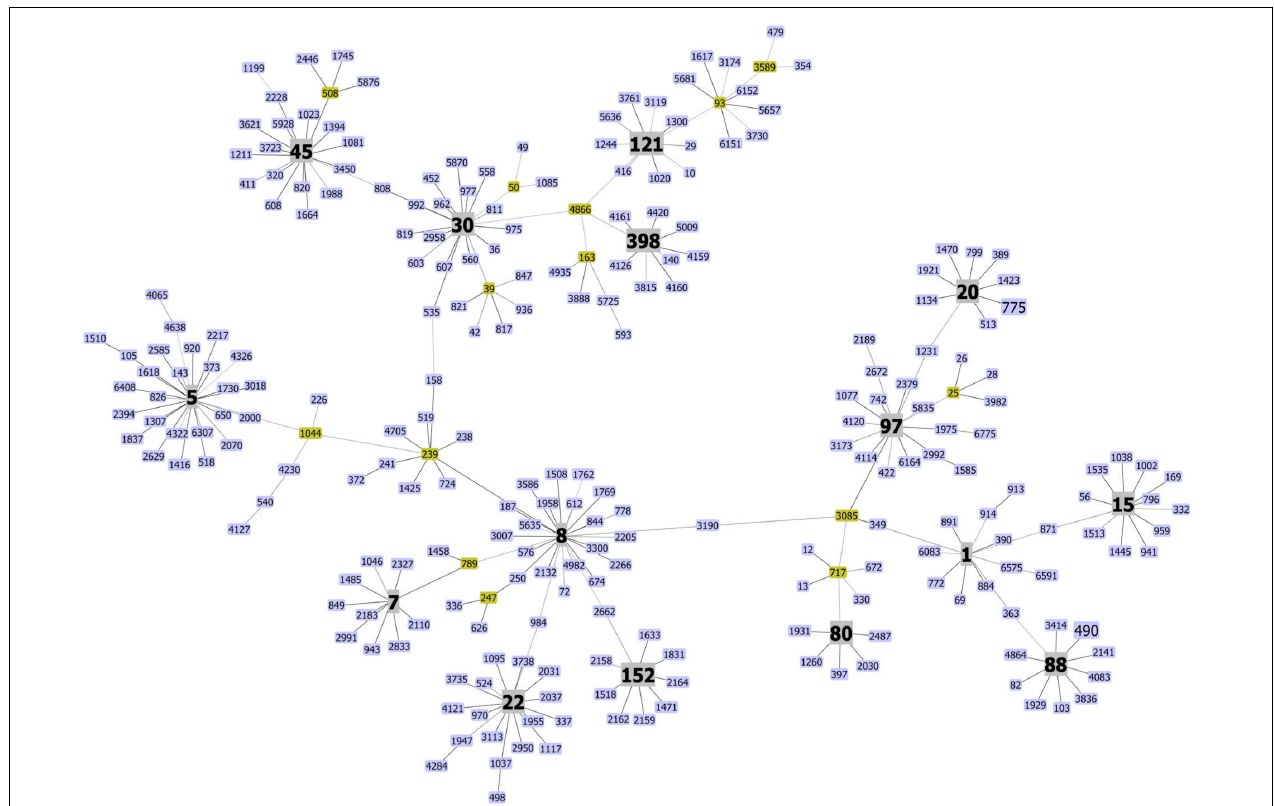
FIGURE 2 | Clonal diversity of methicillin-resistant Staphylococcus aureus in Africa. The minimum spanning tree was constructed with Phyloviz software version 2.0 hosted on http://www.phyloviz.net. The allelic profiles were obtained from the MLST database hosted on (https://pubmlst.org/organisms/staphylococcus-aureus) that included the sequence types of the MRSA described in this review, and 236 randomly selected STs based on the differences in their allelic profiles and representative of the MRSA diversity worldwide. Each node depicts an ST, and nodes centrally located and bearing different colors correspond to a group founder or sub-founder. Clonal complexes (CCs) reported in this study are colored in